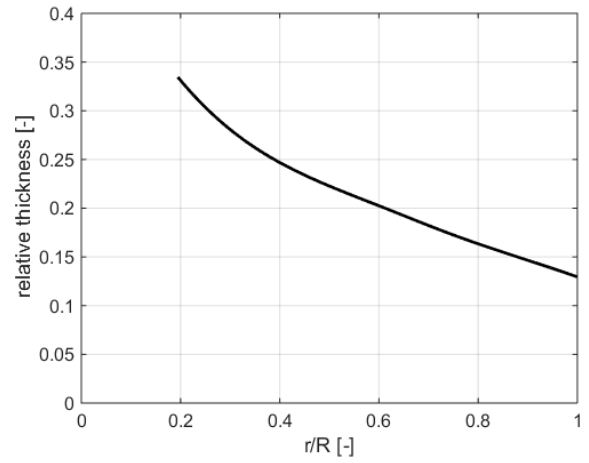
Figure 5. Propeller blade relative thickness distribution.